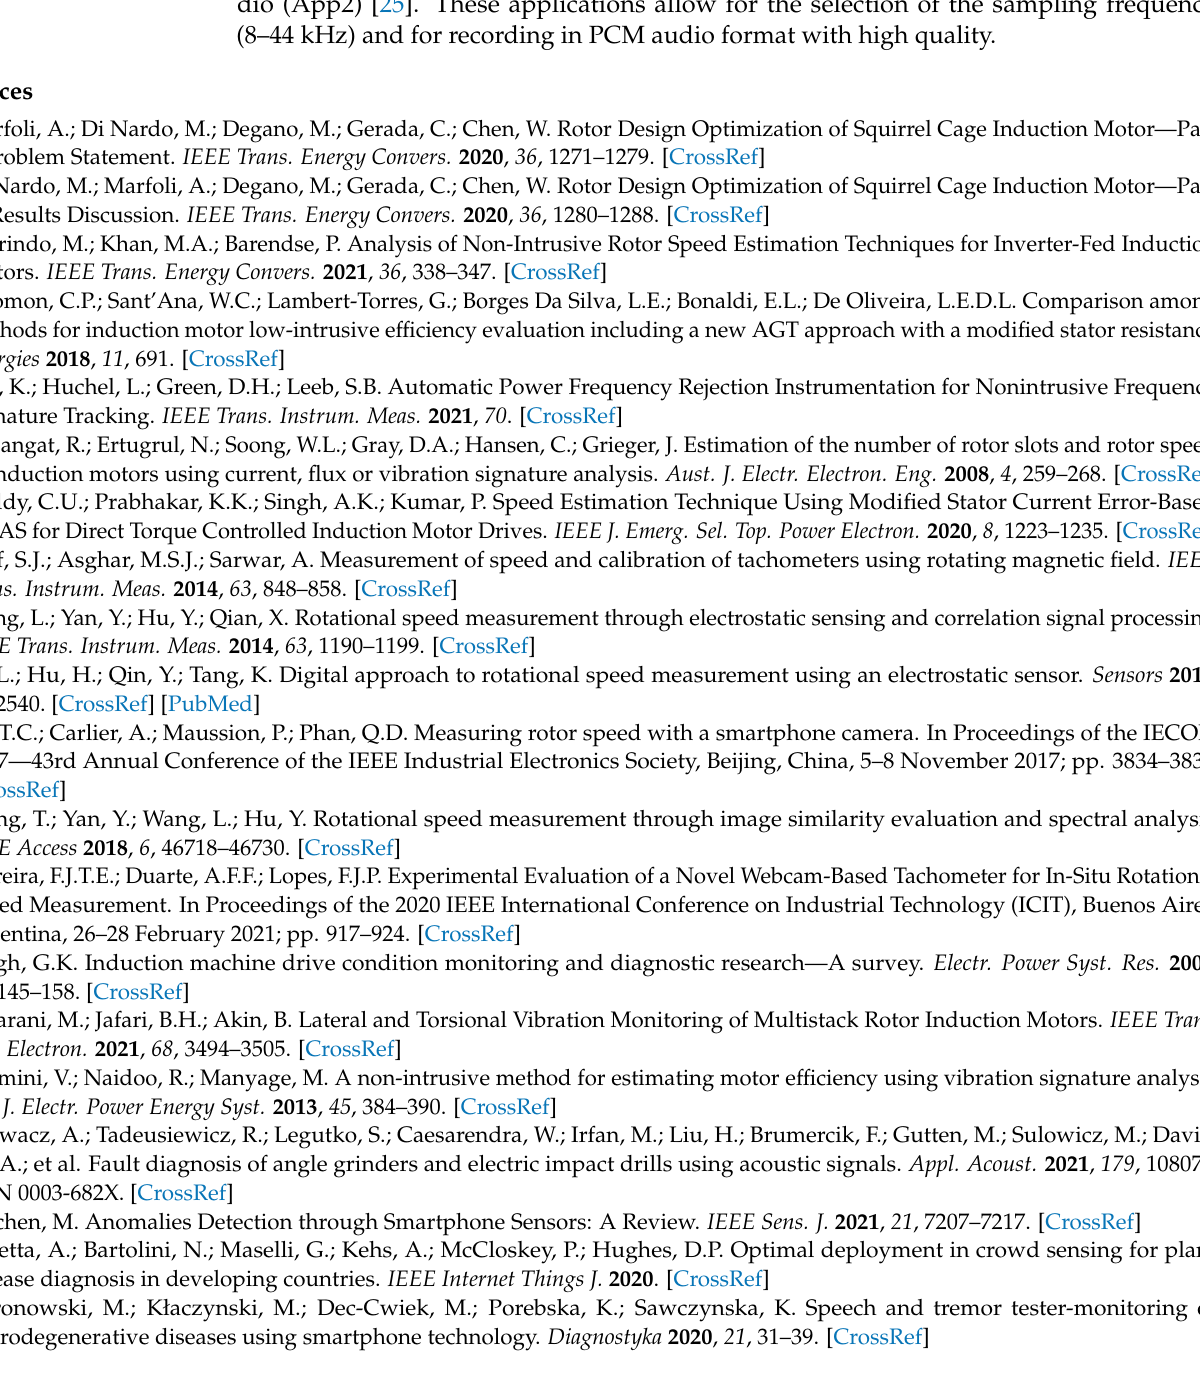
Two smartphones were used to record the audio: (a) smartphone 1 (T1 in this pa- per), a model released in 2014 priced at € 180 and (b) smartphone 2 (T2 in this paper),